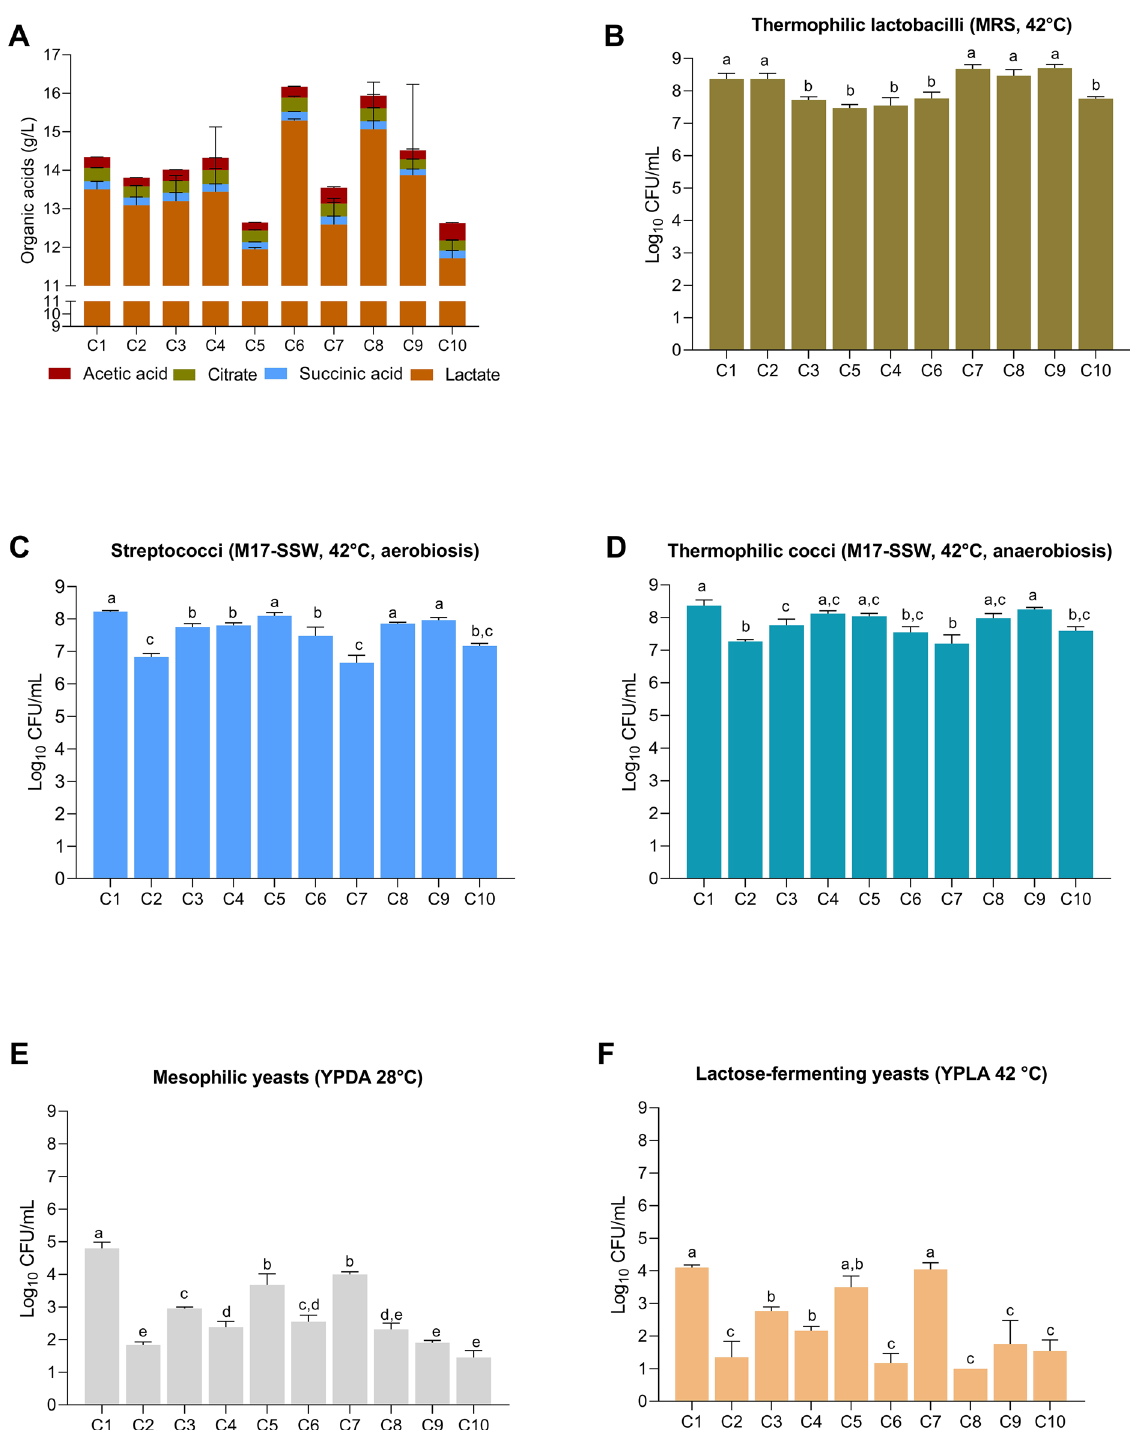
Figure 1. Organic acids contents and microbial counts of ten NWS samples. Organic acids concentrations are expressed in g/L as means ± standard deviation of four replicates ( A ). Microbial counts of presumptive lactobacilli ( B ), streptococci ( C ), cocci-shaped LAB ( D ), mesophilic yeasts ( E ), and lactose-fermenting thermophilic yeasts ( F ) are expressed as means of Log 10 CFU/mL of at least three replicates. Significant differences are indicated with different letters ( p < 0.05), as calculated by one-way ANOVA. Plotted with GraphPad Prism v.8.00 software (San Diego, CA, USA, https:// www. graph pad.